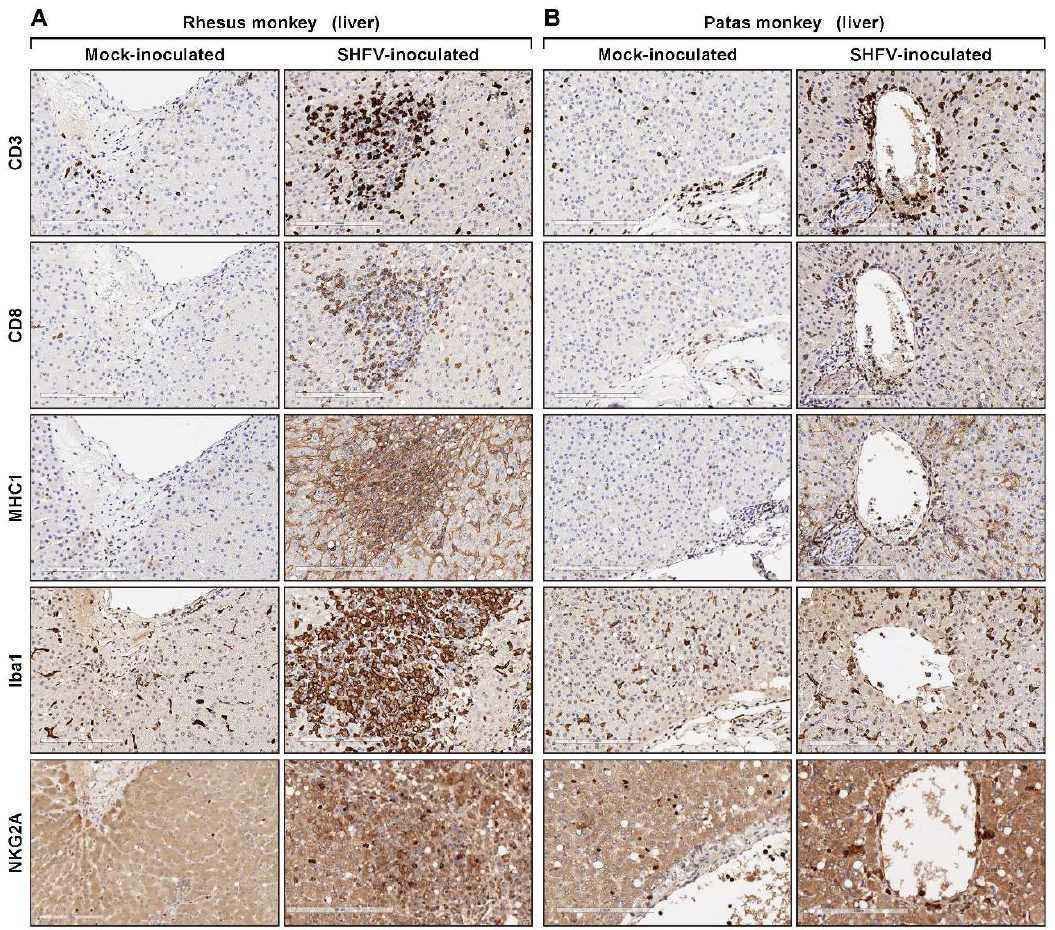
Figure 3. Representative images showing liver immunohistochemistry staining of the indicated markers for SHFV-inoculated rhesus ( A ) and patas ( B ) monkeys Scale bar represents 200 µm. SHFV was detected by plaque assay in the axillary lymph node ( n = 1), spleen ( n = 1),